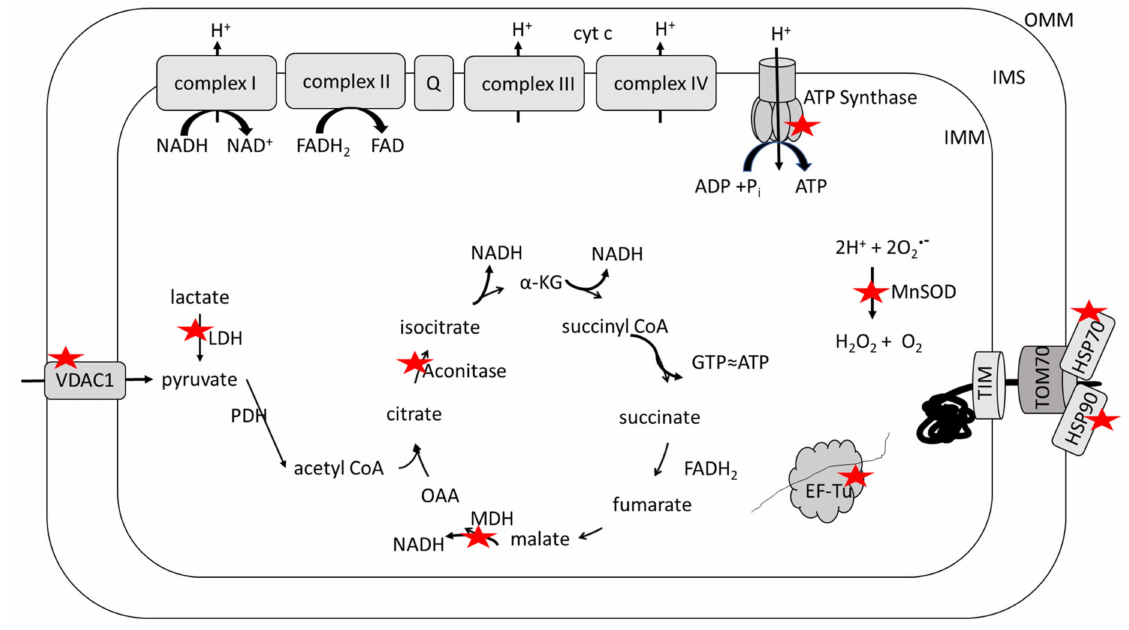
Figure 3. Redox proteomics identified oxidatively modified, mitochondrial proteins in brains from persons with Alzheimer disease or amnestic mild cognitive impairment. Proteins marked with a red star are oxidatively modified. Functional classes of oxidatively dysfunctional proteins include those related to: Glucose metabolism, i.e., lactate dehydrogenase (LDH), aconitase, malate dehydrogenase (MDH), ATP synthase; Export of anions (ATP, for example, has a decreased chance of export through voltage-dependent anion channel 1 (VDAC1) to drive neuronal function including the maintenance of mitochondrial potential); Free radical scavenging (MnSOD, which increases opportunities to cause further oxidative and nitrosative damage to mitochondria); mitochondrial protein synthesis (EF-Tu, which would lead to altered levels of key proteins needed to assemble into functional inner membrane resident electron transport complexes and thereby decrease ATP levels); and chaperone and transport function for the import of nuclear-encoded proteins into mitochondria (heat shock protein 70 (HSP70); heat shock protein 90 (HSP90), which also could contribute to altered protein levels of needed electron transport chain [(ETC) complexes and other key proteins]. See text for further